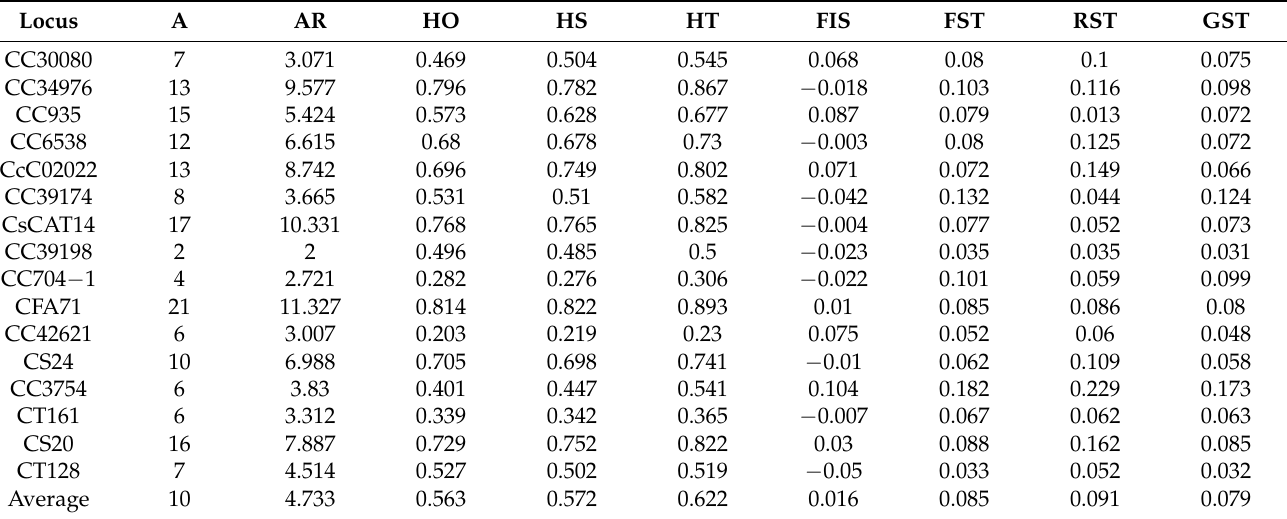
Table 3. Genetic diversity of Castanopsis sclerophylla at the 16 retained microsatellite loci.